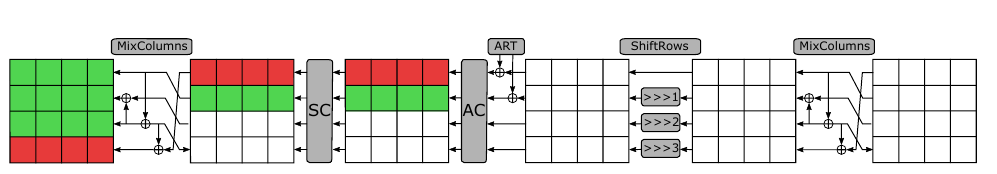
Figure 9: The influence of the round key on the internal state after a round. The red lines show dependencies on the first byte of the key and the green lines on the second byte.